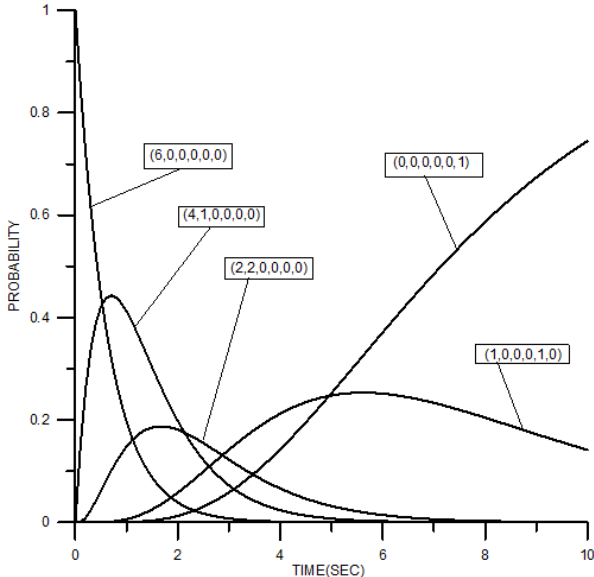
Figure 2. Time evolution of the probability for 5 of the 11 the states for the initial condition P( 6 , 0 , 0 , 0 , 0 , 0 ; 0 ) = 1 and the collection kernel K(i,j) = (i 1 / 2 + j 1 / 2 )/